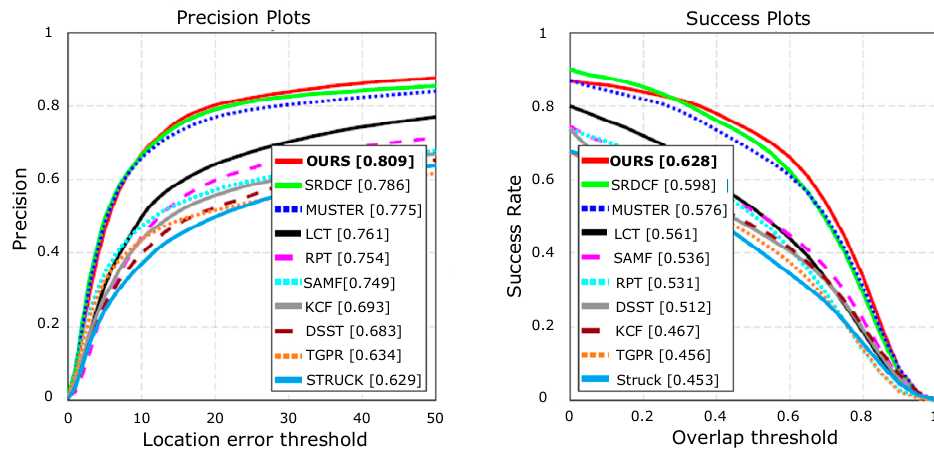
Figure 5. Evaluation on OTB100 benchmark.